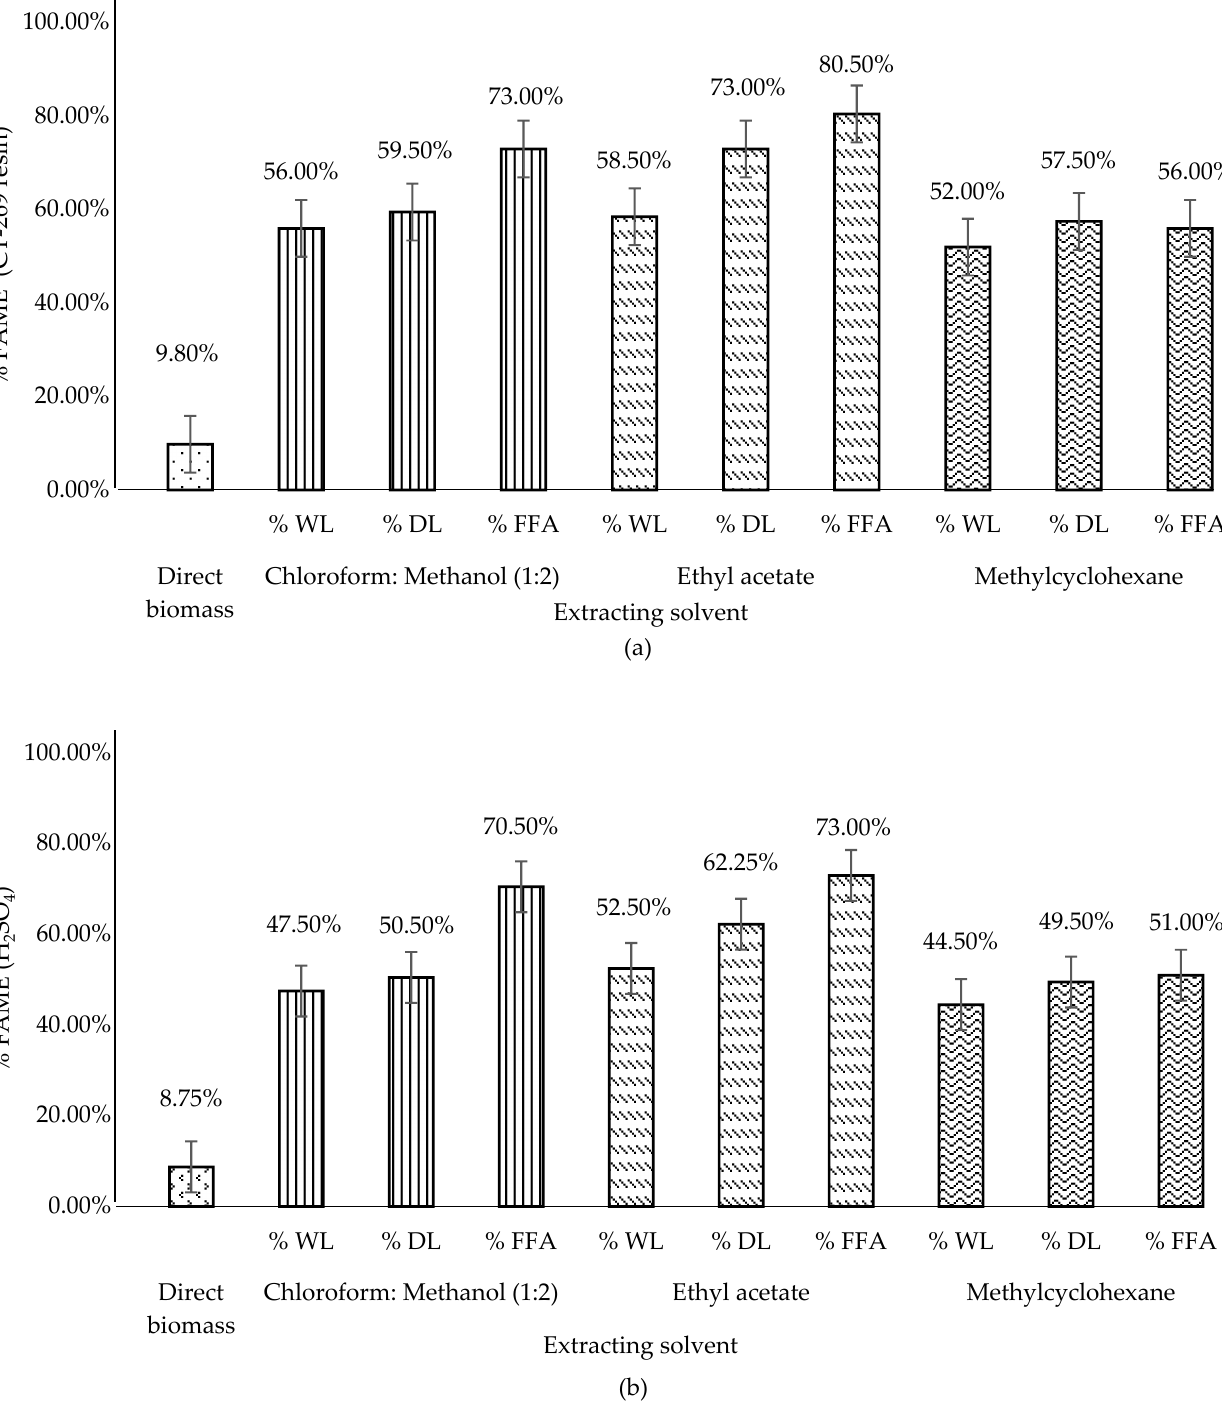
Figure 7. Fatty acid methyl esters weight content of Chlorella vulgaris with the three best extracting solvents using different direct biomass, lipids from wet biomass (WL), lipids from dry biomass (DL) and lipids from FFA (FFA) with two catalysts ( a ) CT-269 resin and ( b ) sulfuric acid (H 2 SO 4 ). The values are presented as means of triplicate measures with their corresponding standard deviation (±SD).